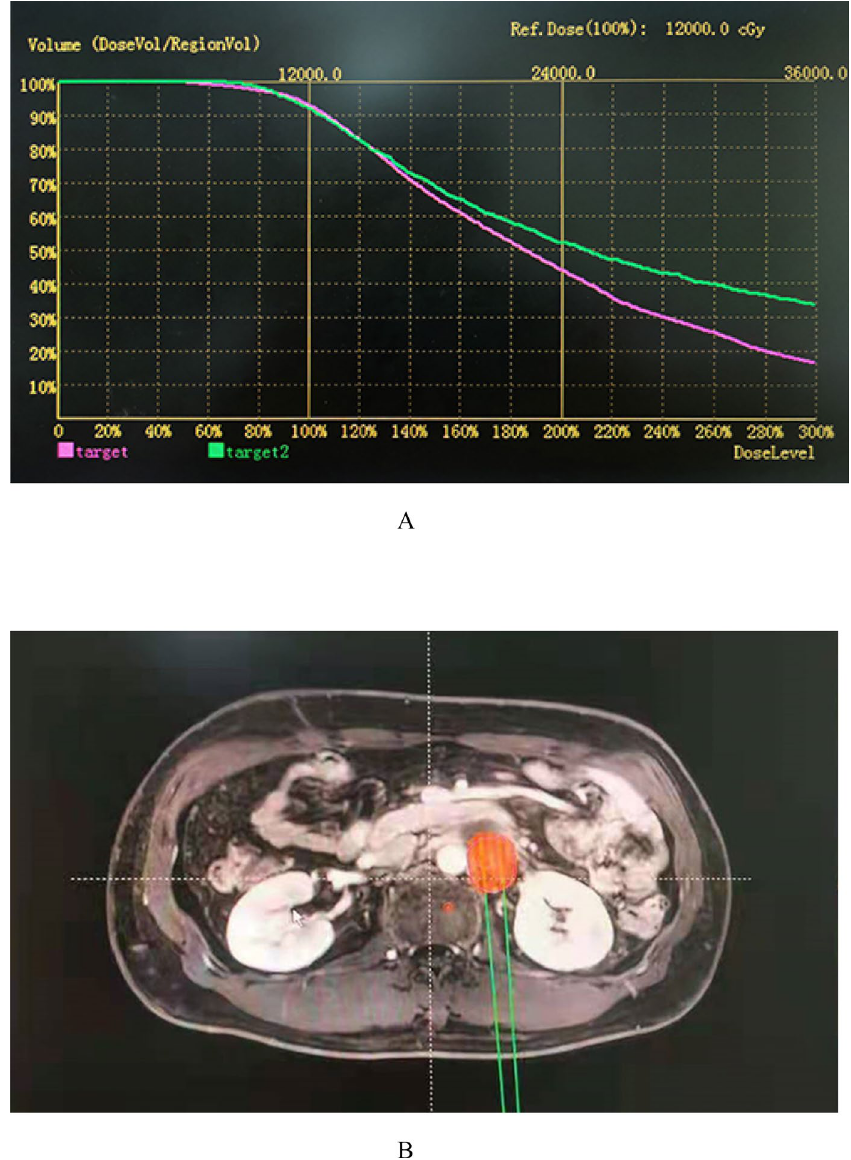
Figure 5. A 50-year-old patient with a tumor of common iliac lymph node recurrence after cervical cancer surgery. ( A ) Radiotherapy specialists design dose-volume histograms on a treatment planning system based on the patient’s tumor profile. ( B ) The location and dose of 125 I seeds were calculated using two-dimensional images of the tumor from the treatment planning